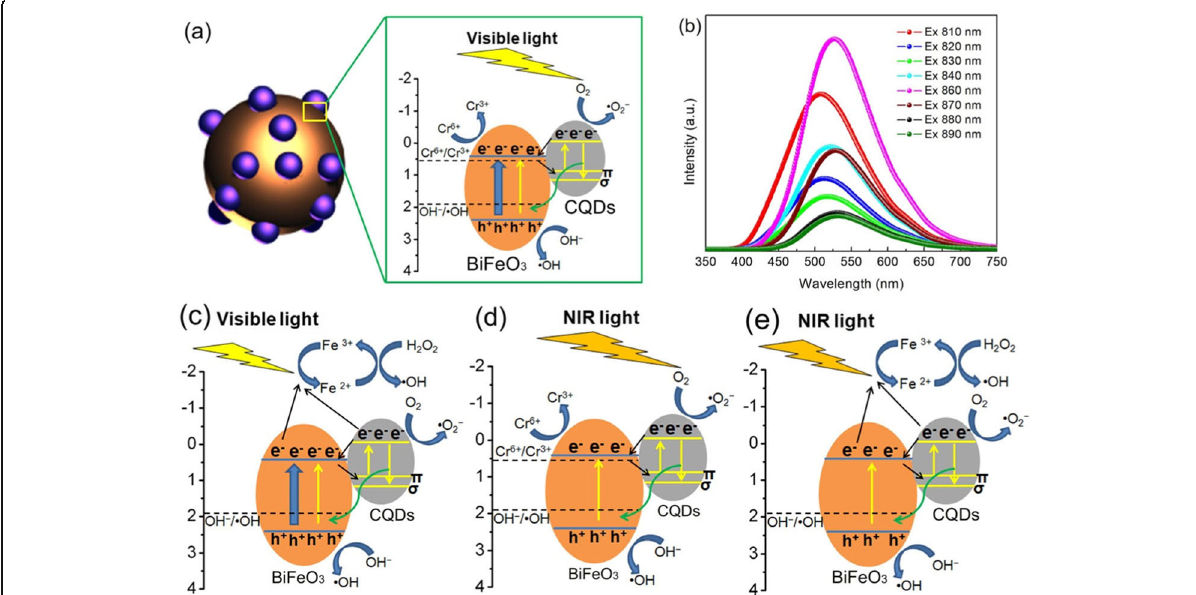
Fig. 13 a Photocatalytic degradation mechanism of AO7 over the CQDs/BiFeO 3 composite photocatalysts under visible light irradiation. b Up- converted PL spectra of CQDs under different excitation wavelengths. c Photo-Fenton catalytic degradation mechanism of AO7 over the CQD/ BiFeO 3 composites under visible light irradiation. d NIR light photocatalytic mechanism of the CQDs/BiFeO 3 composites. e NIR light photo-Fenton mechanism of the CQD/BiFeO 3